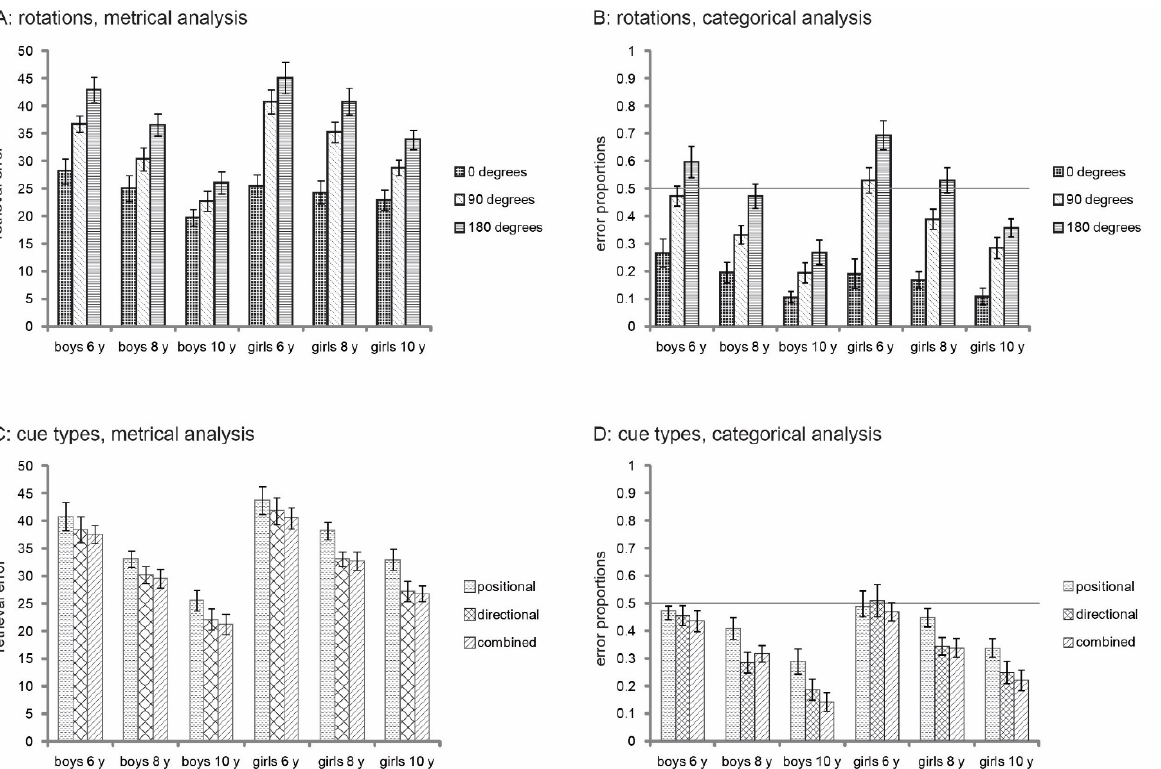
Figure 2. Results for all Age *Sex groups on the cue types and rotations displaying means and standard errors. ( A , C ) present the retrieval errors in Blender units. ( B , D ) present the categorical errors in proportions. The horizontal line in ( B , D ) represents the chance level with bars higher than this level representing at/lower than chance level.